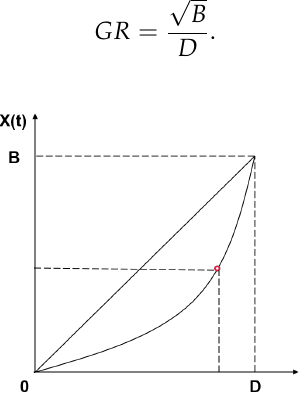
Figure 2. Game information process: certainty of